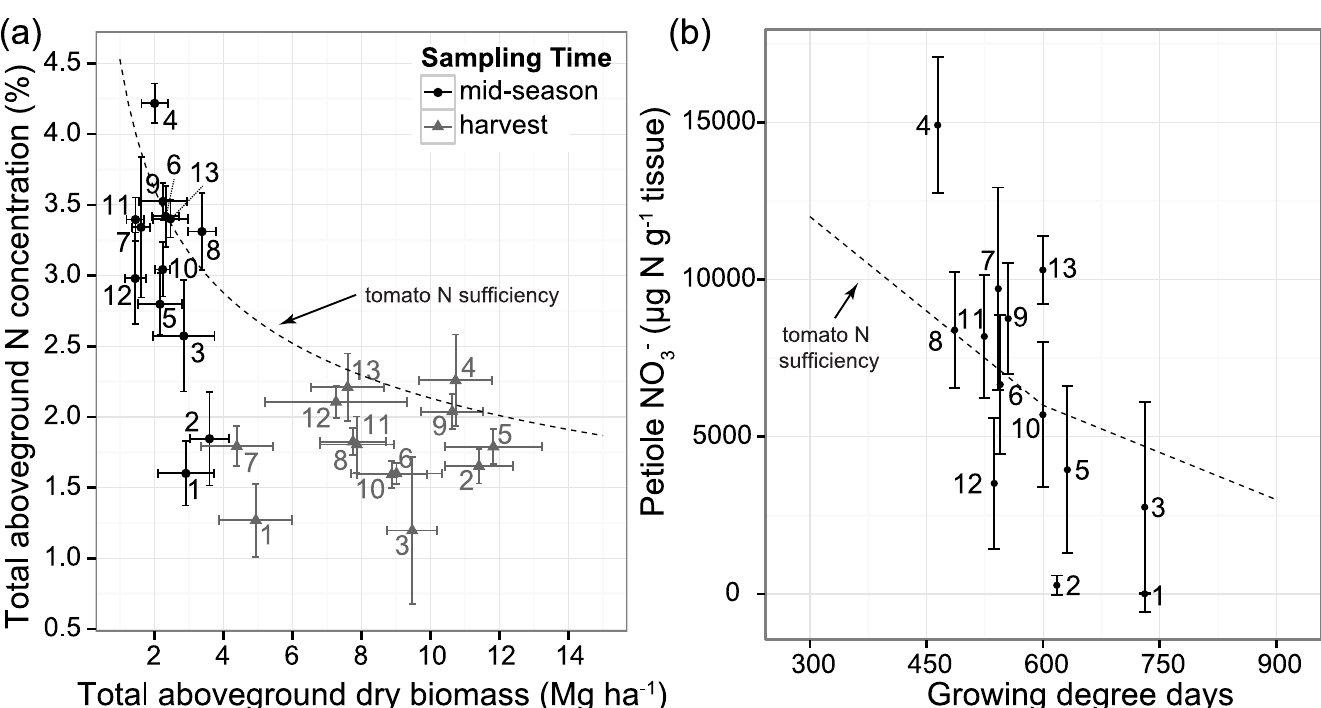
Fig 5. Two measures of tomato N status. Plants were sampled from 13 organically-managed Roma-type tomato fields in Yolo Co., California, USA. a) Whole plant N concentration at two sampling times (mid-season and harvest) relative to the critical N concentration for processing tomatoes (dotted line, N c = 45.3×dry biomass -0.327 [68]); and b) petiole NO 3- concentration at mid-season sampling. Since petiole NO 3- rapidly changes, concentrations are given in terms of growing degree days to correct for slight variations in sampling time in each field. The dotted line shows current tissue sufficiency guidelines for petiole NO 3- based on conventional processing tomato production [54].